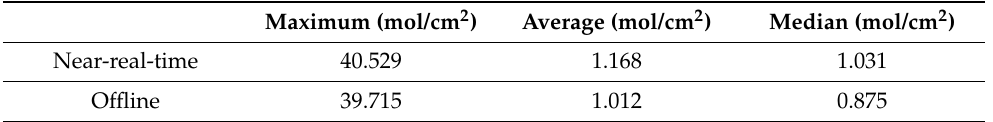
Table 4. Statistic comparison of TropOMI’s two types of tropospheric NO 2 column